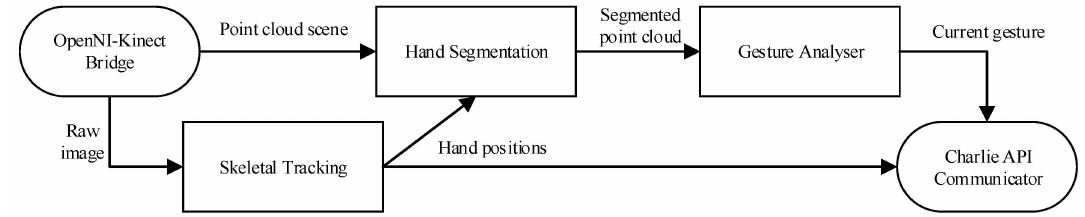
Figure 3. Data flow among the different software components of the